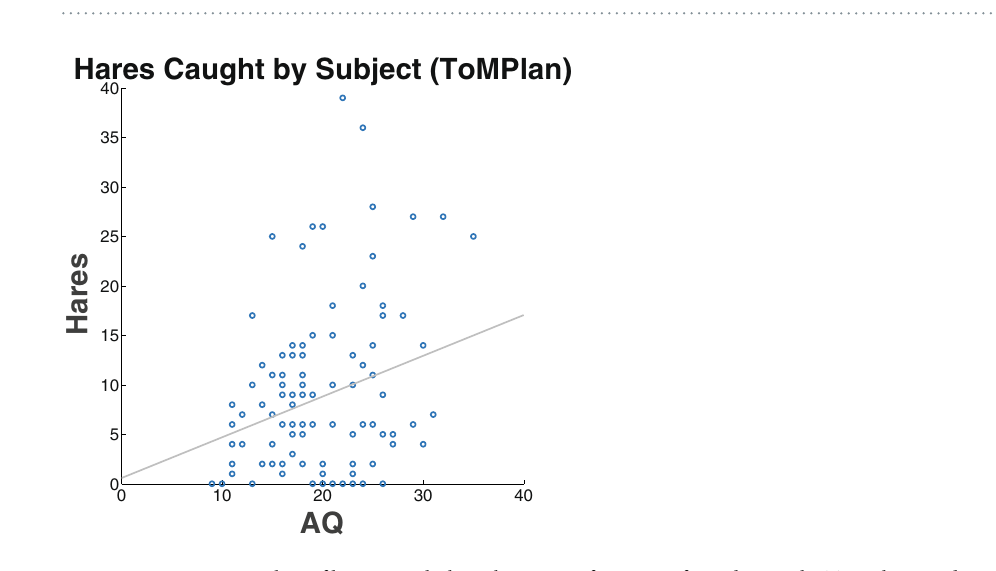
Figure 4. The number of stags caught as a function of AQ. ( A ) ToMPlan. The number of stags caught in the ToMPlan condition was significantly negatively correlated with AQ (r = − 0.276, p < 0.002). ( B ) Random. The number of stags caught in the Random condition was significantly positively correlated with AQ (r = 0.234, p < 0.008). The x-axis is AQ ranging from 0–40, the y-axis is the number of stags out of a possible 50, and the regression line is included.